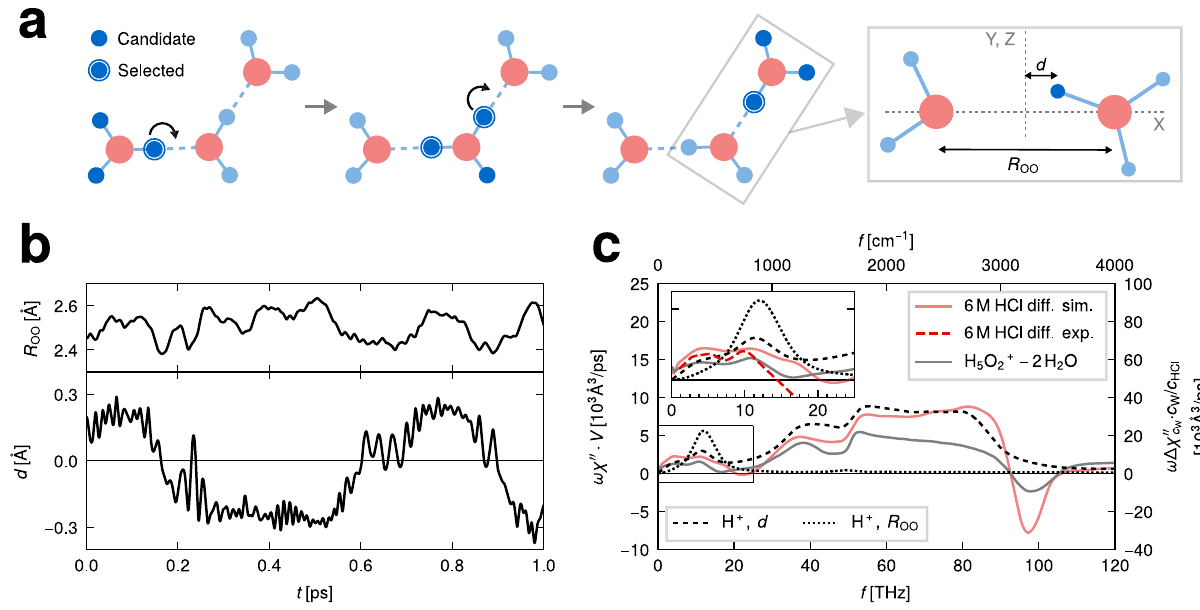
Fig. 3 Excess-proton trajectories and spectra. a Illustration of the method used to extract continuous excess-proton trajectories from ab initio molecular dynamics (MD) simulations. From the three protons in a hydronium ion, the one that will later transfer to a neighboring water is identi fi ed as excess proton. To the right the coordinates d and R OO are de fi ned. b Example trajectories of the d and R OO coordinates. c Power spectra of the d and R OO coordinates are shown as broken and dotted black lines, respectively (vertical axis on the left). Also shown are the simulated difference spectrum of the 6 M HCl solution, divided by the HCl concentration c HCl and multiplied by the water concentration c W (red solid line), and the simulated difference spectrum between a transient H 5 O 2 + complex in HCl solution and two hydrogen-bonded water molecules in pure water (gray solid line), using the vertical axis on the right. The inset shows a zoom into the THz regime, which additionally shows our 6 M experimental THz/FTIR difference spectrum (red broken